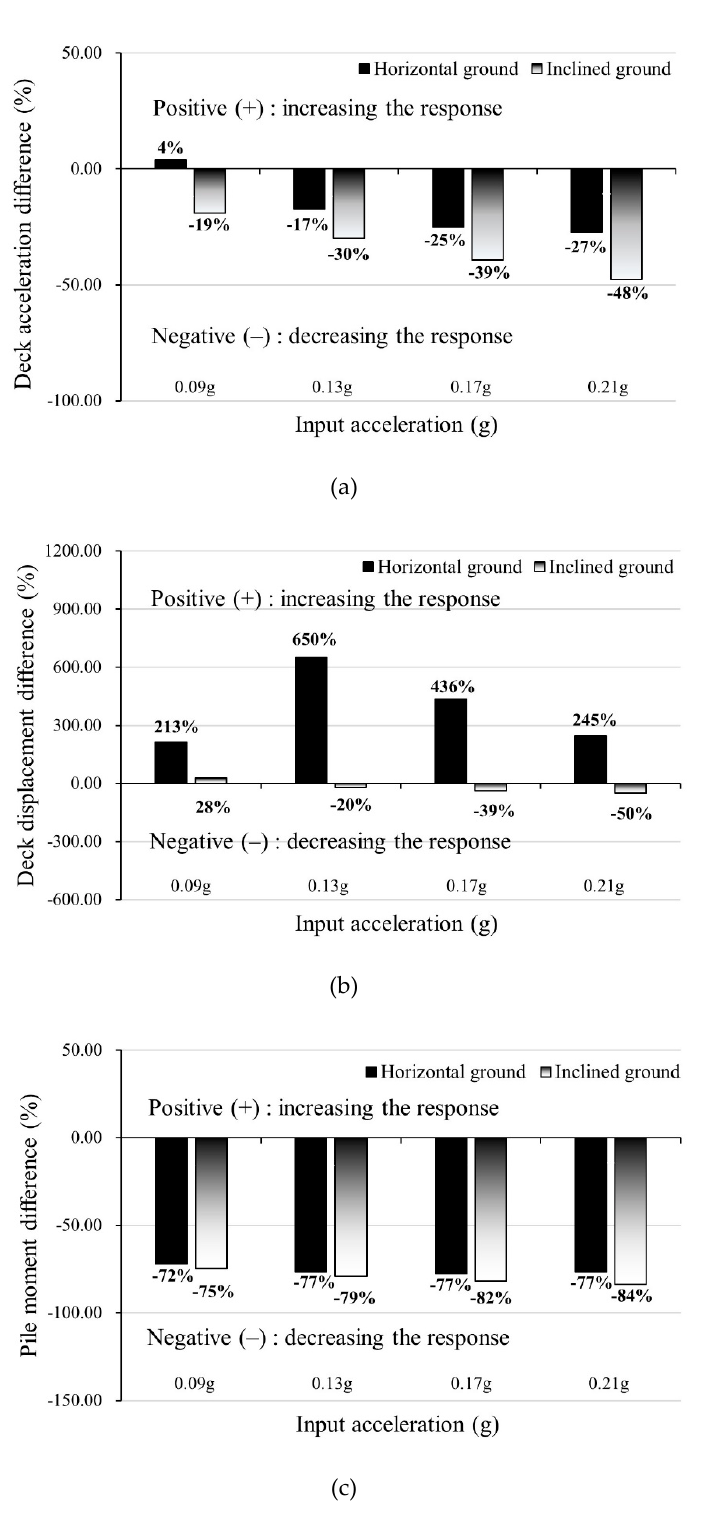
Figure 14. Difference in response with and without the batter pile according to the ground slope: ( a ) peak acceleration of deck plate; ( b ) horizontal residual displacement of deck plate; and ( c ) maximum moment of vertical pile.